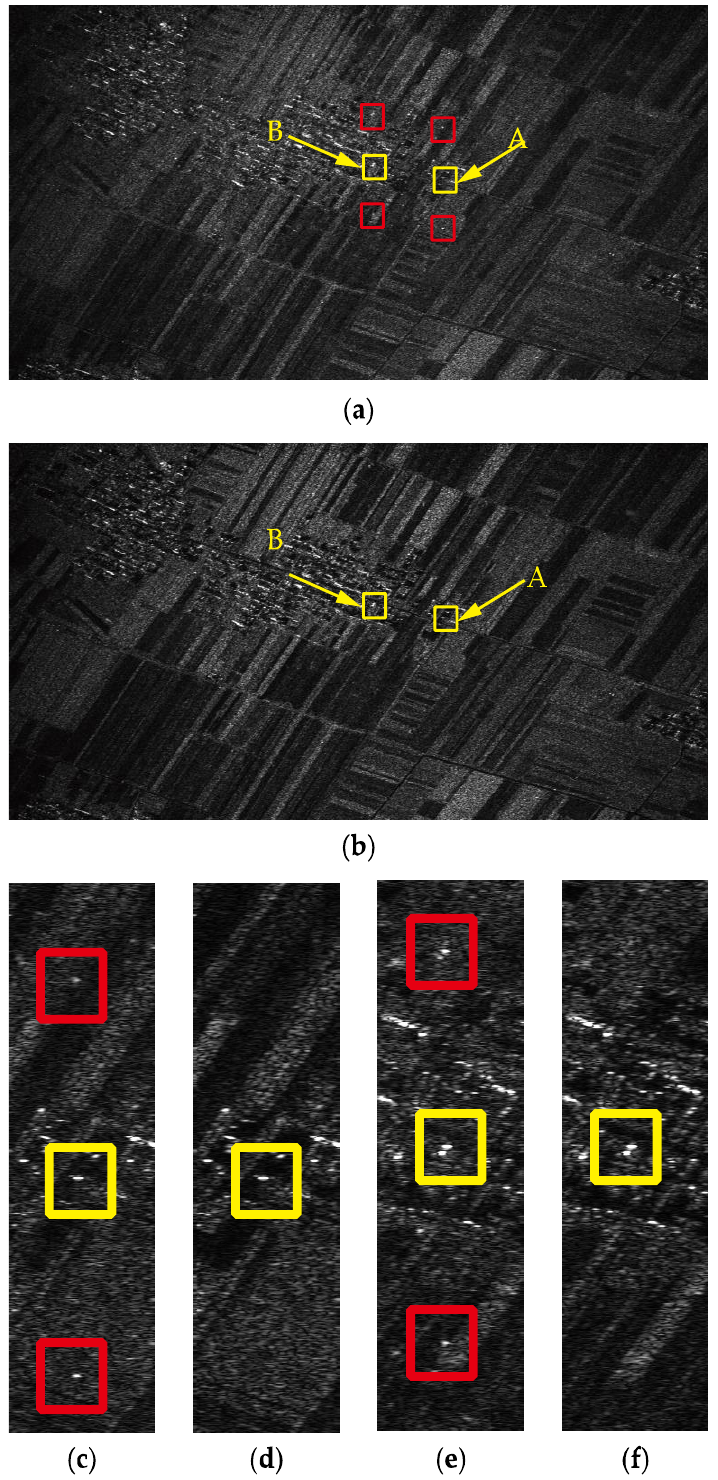
Figure 13. Distributed SAR HRWS imaging results. ( a ) Imaging results after estimation and compensation of channel error by the traditional method, ( b ) imaging results after estimation and compensation of signal error by the proposed method, ( c ) results of the traditional method for Target A, ( d ) results of the proposed method for Target A, ( e ) results of the traditional method for Target B, and ( f ) results of the proposed method for Target B.